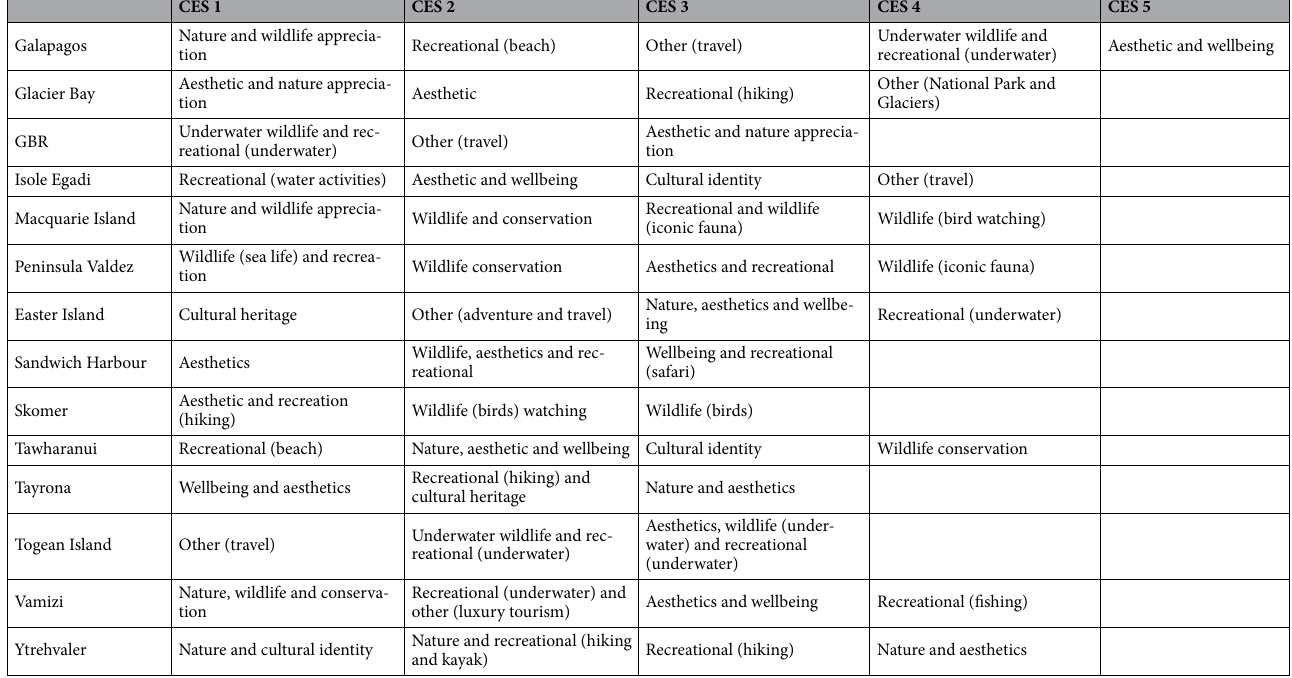
Table 2. Cultural Ecosystem Services’ types (CES) depicted from the community analysis (Fast Greedy algorithm). The order of the CES class does not imply a priority